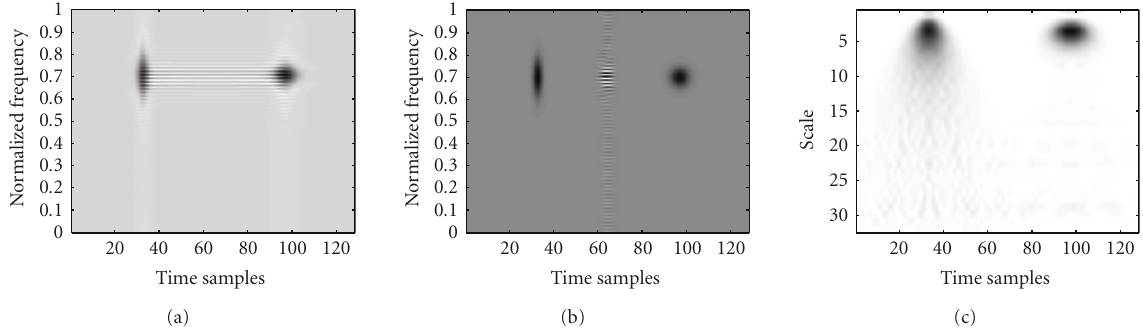
Figure 2: Scale covariant distribution for a Gabor logon and its time-scaled version. (a) Scale covariant distribution, (b) Wigner distribution, and (c) Wavelet distribution using the Morlet wavelet.